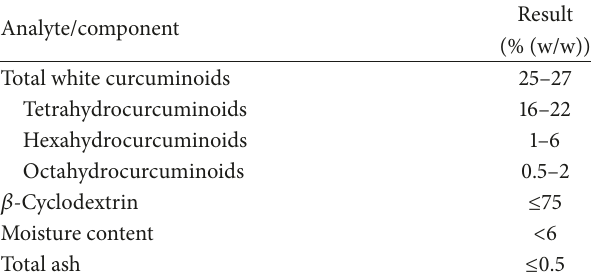
Table 1: Compositional specifications of